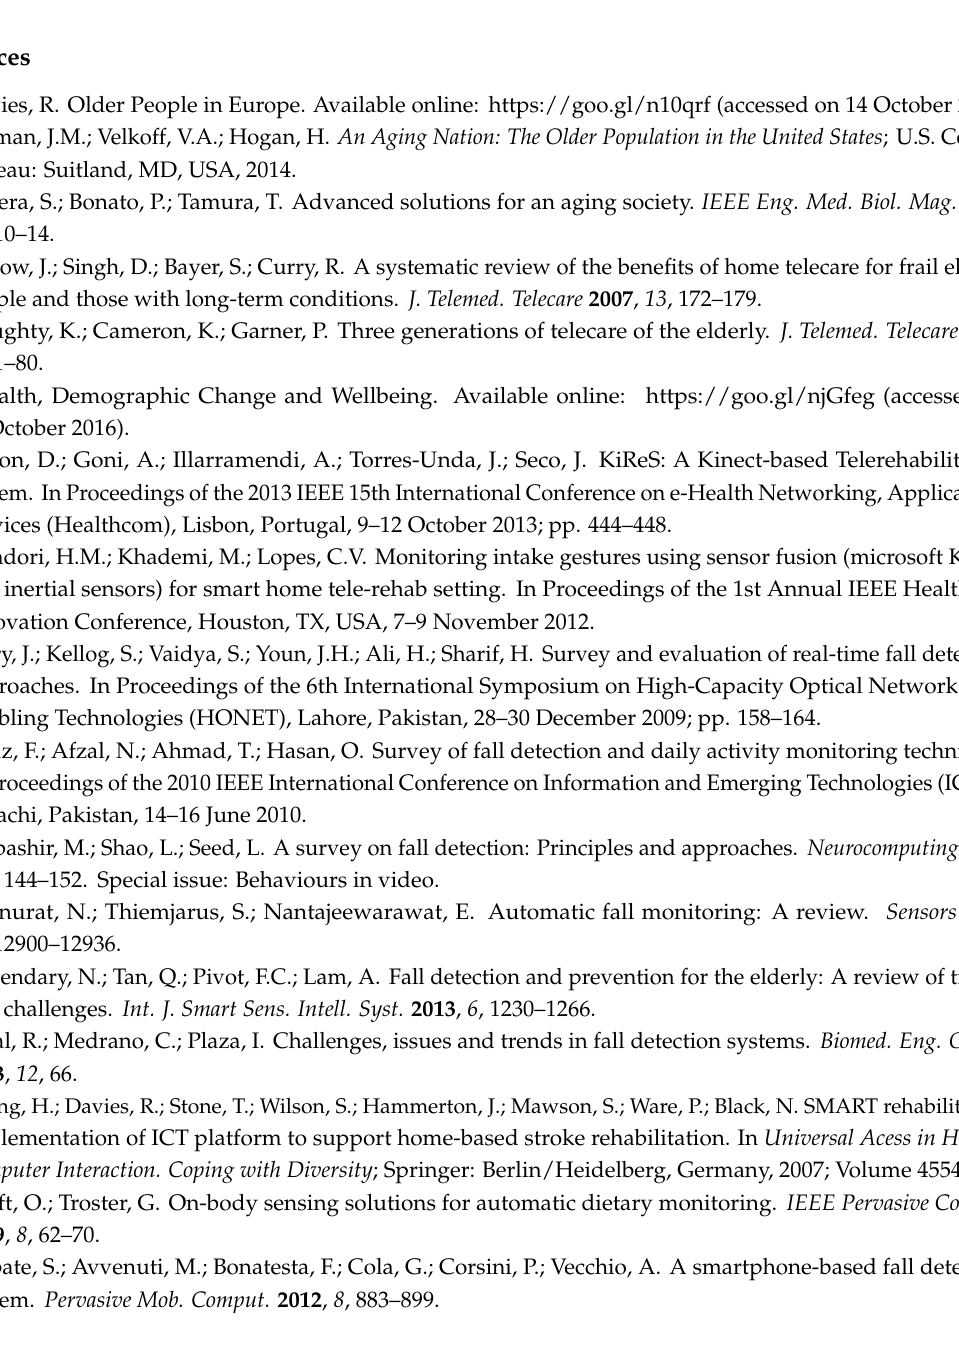
Figure B4. Urgent situation